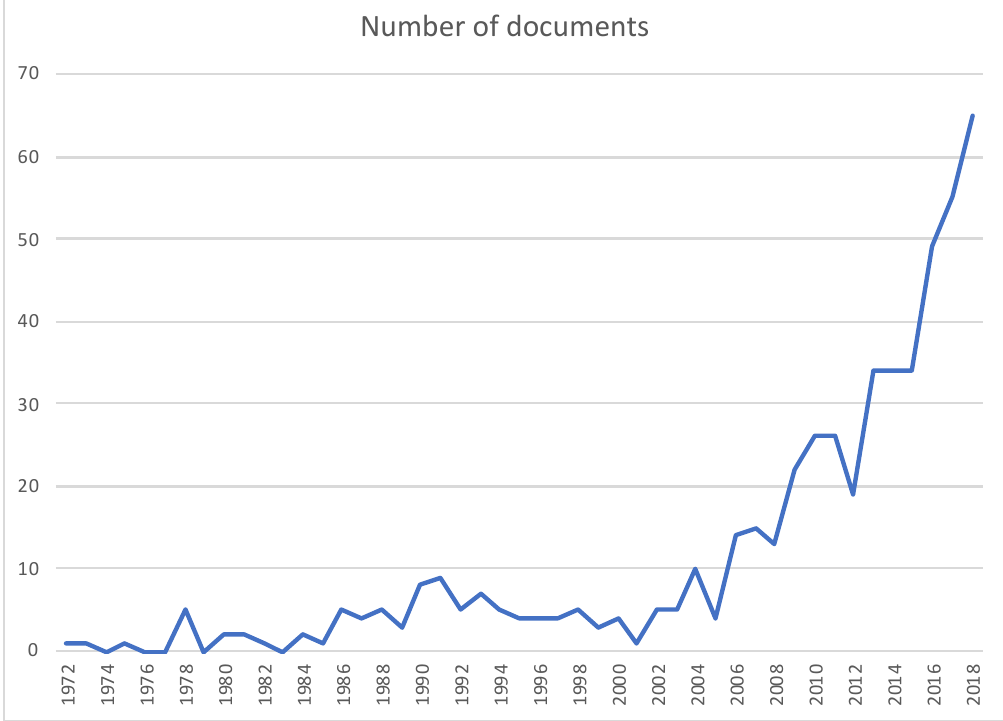
Figure 2. The time series of published items in the Scopus database, 30 April 2020, keywords spatial exploration, economic data, education. (Source: Authors’ research, based on Scopus data).